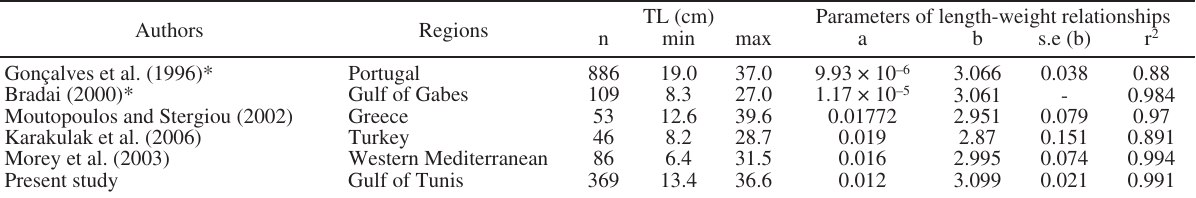
Table 2. – Biogeographic comparison of parameters of length-weight relationships of Spondyliosoma cantharus . *, authors utilizing TL in mm; n, sample size; a, intercept; b, slope; s.e. (b), standard error of b; r 2 , coefficient of determination. Authors